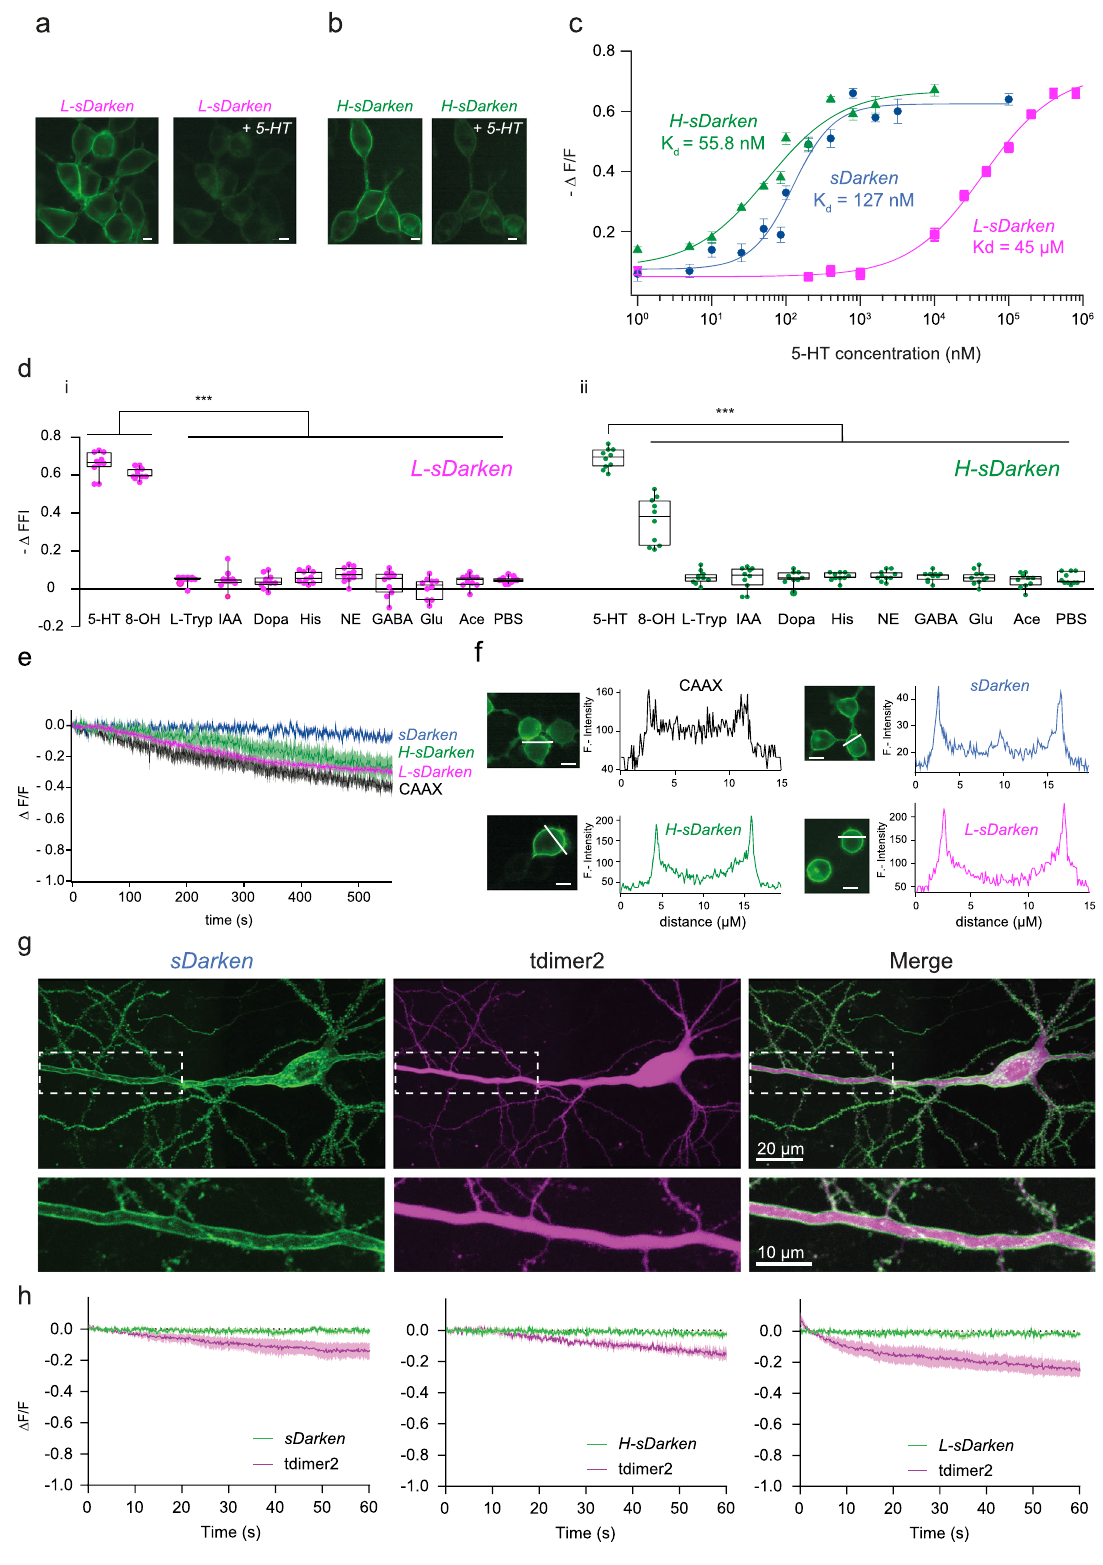
2-Photon imaging in organotypic hippocampal slice cultures To evaluate the ability of the sensor to report serotonin-binding as observed in HEK cells, we bath-applied serotonin to hippocampal neurons. As expected, all three variants displayed a strong dimming in brightness, measured along dendrites and individual spines, con fi rm- ing functionality of the sensors in neuronal